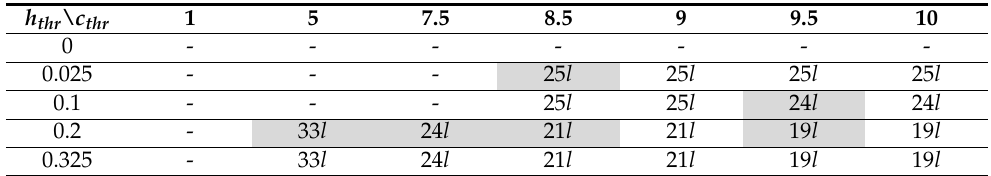
Table 3. Values of 𝑓 1 at (ℎ 𝑡ℎ𝑟 ,𝑐 𝑡ℎ𝑟 ) for problems (9) – (13) applied for the graph in Figure 3b; Pa- reto-optimal solutions are shaded. 0.1 0.1